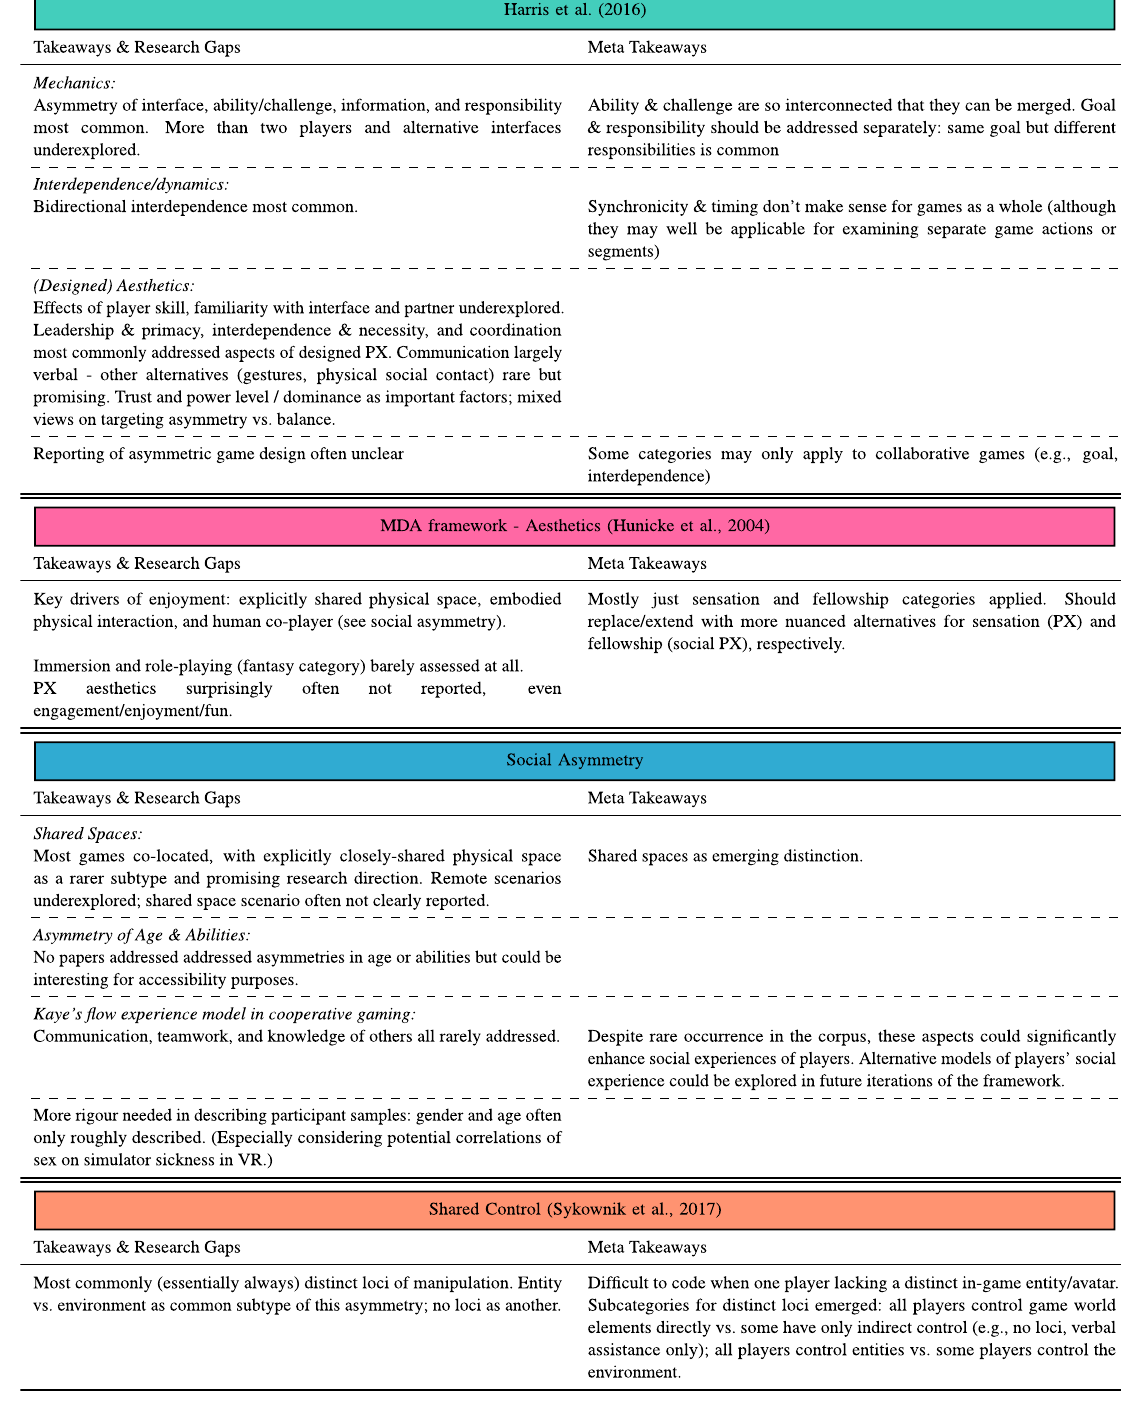
TABLE 3 | Summarized overview of takeaways and research gaps from the review synthesis, as well as meta takeaways that led to the adjustment of the a priori framework to develop the posthoc framework.